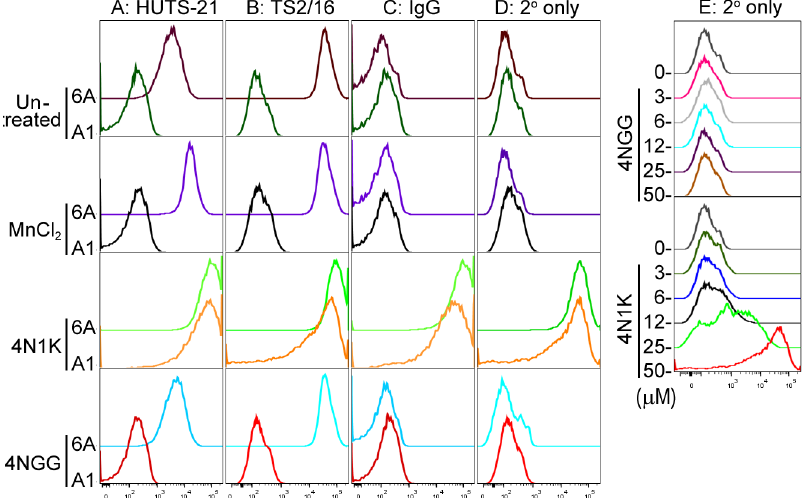
Figure 2. Incubation of Jurkat cells with 4N1K results in non-specific binding of various antibodies. Jurkat 6A or A1 cells were incubated without or with treatment (1 mM MnCl 2 , 50 m M 4N1K or 50 m M 4NGG) for 30 min at 37 u C, along with one of three antibodies: A) HUTS-21 to detect activated epitopes of b 1-integrins, B) TS2/16 to detect total b 1-integrins, C) a non-specific IgG control antibody, and D) no primary antibody control treatment. Cells were then washed, incubated with fluorophore-conjugated secondary antibody, and antibody binding was assessed using flow cytometry. E) Flow cytometry data of A1 cells incubated with the indicated concentrations of 4NGG or 4N1K peptide and fluorophore-conjugated secondary antibody. Histogram data as shown is for one experiment that is representative of three independently conducted